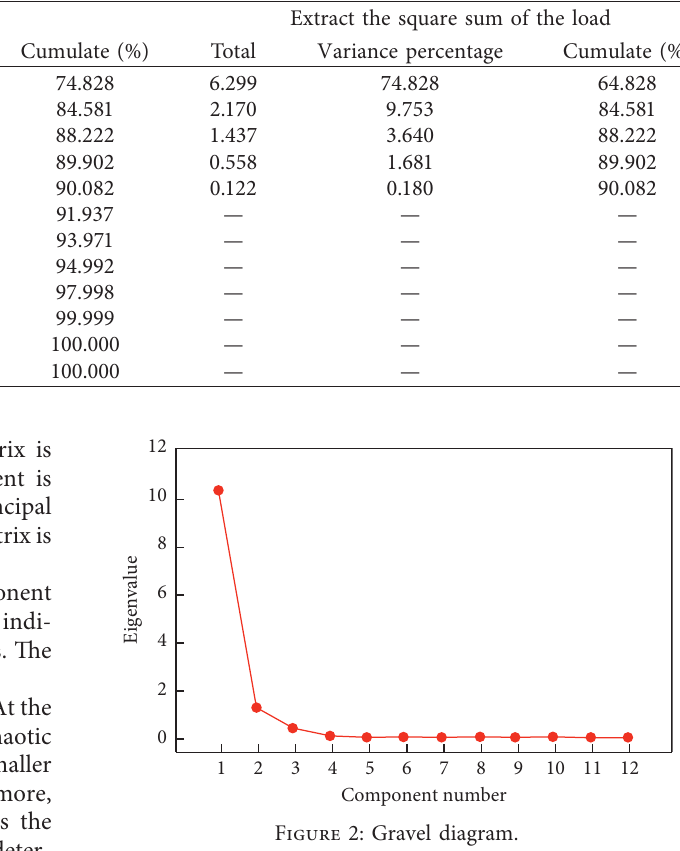
Figure 1: Classification of higher education system indicators. Table 1: Total variance explanation.